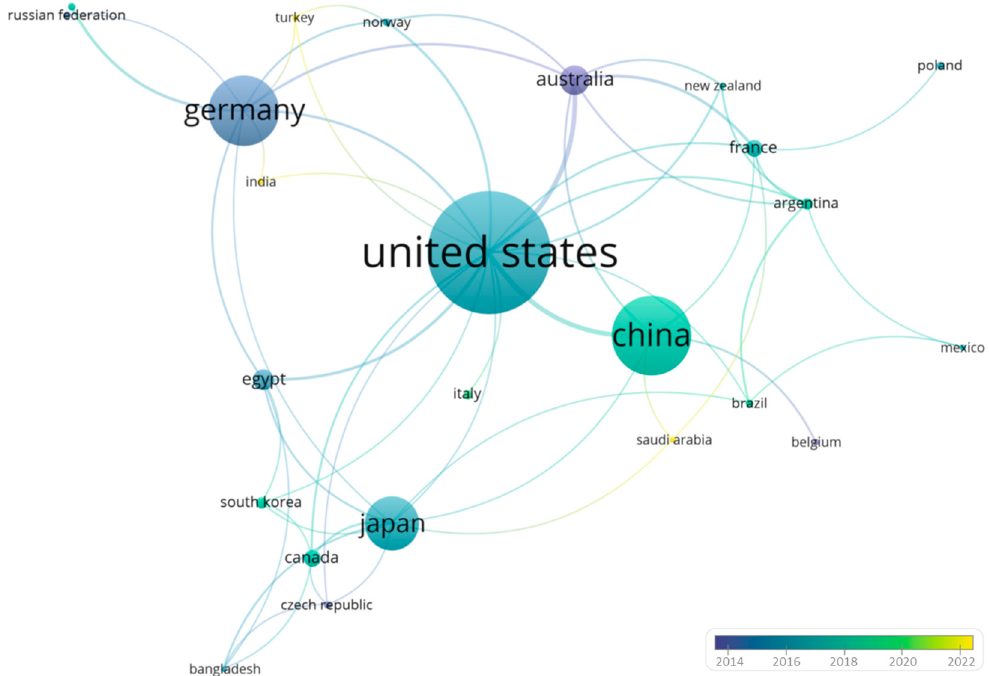
Figure 4. Network Mapping showing the existing co-authorship relationships among countries involved in the publication of scientific articles related to the role of biogenic amines in social insects. The blue-dark bubble is associated with the country when the involvement is less recent, while the yellow bubble refers to countries that have contributed more recently to the research topic. Finally, the size of the nodes indicates their frequency, while the curves between the nodes represent their co-authorship in the same publication.